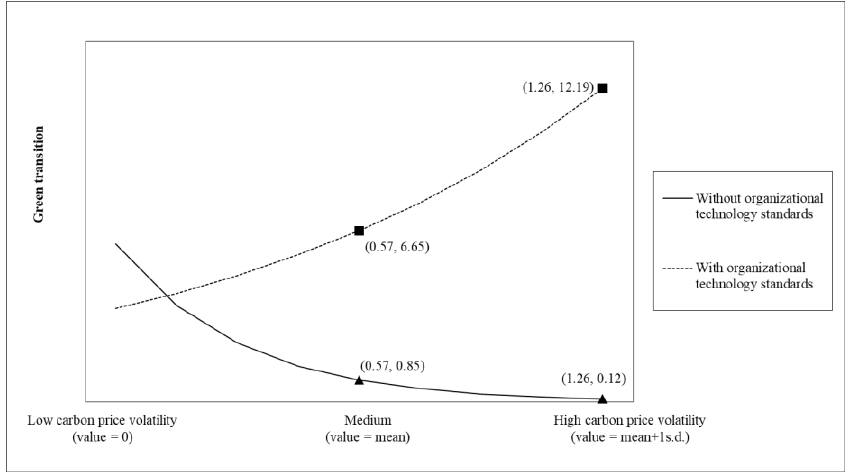
Figure 1. The moderating effect of resource slack on the green transition.